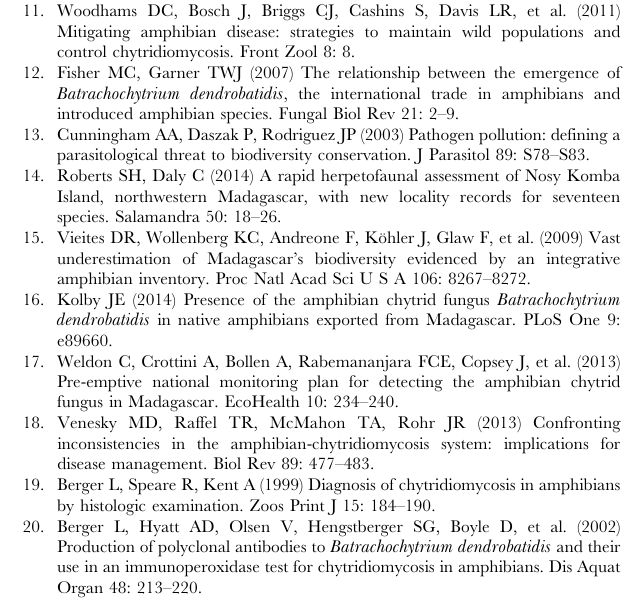
Figure S1 Boxplot of zoospore genomic equivalents (ZGEs) as a function of Bd sampling method (n =49 filter samples, 11 swab samples). Median, interquartile range (box), and range (whiskers) are shown. (TIF)